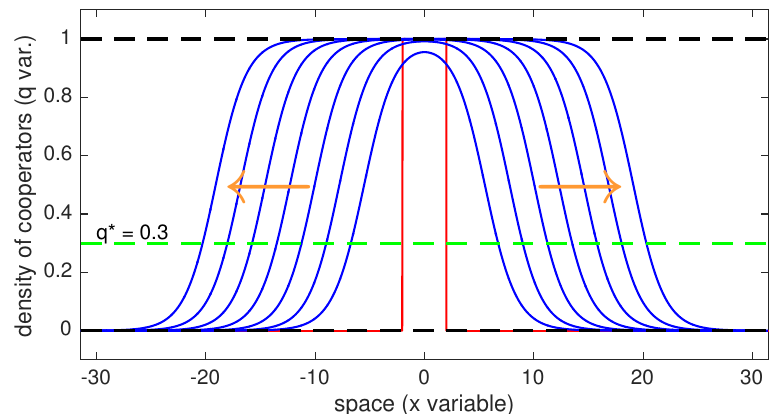
Figure A1. The figure shows a numerical simulation in one dimension where an initially concentrated cluster of cooperators (red line) above the fraction q ∗ (green dashed line) invades the whole space slowly reaching everywhere the quota q = 1. The thin blue lines represent time-evolution and the orange arrows show the direction of the invasion.